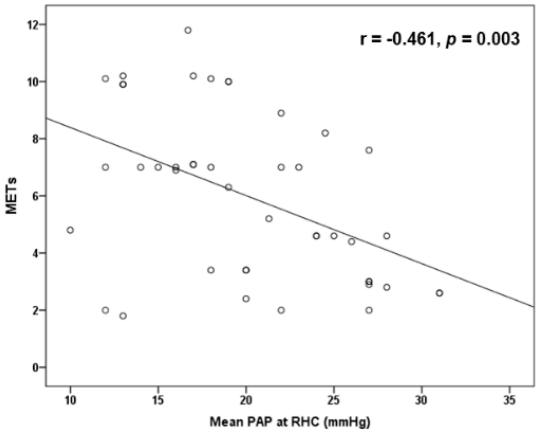
Figure 3. Scatter plot inverse correlation of maximal achieved workload in METs with resting mean pulmonary arterial pressure (PAP) at right-heart catheterization (RHC).